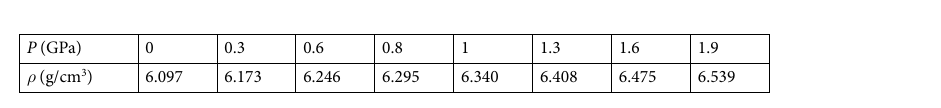
Table 1. The densities of liquid gallium at ambient temperature under various pressure